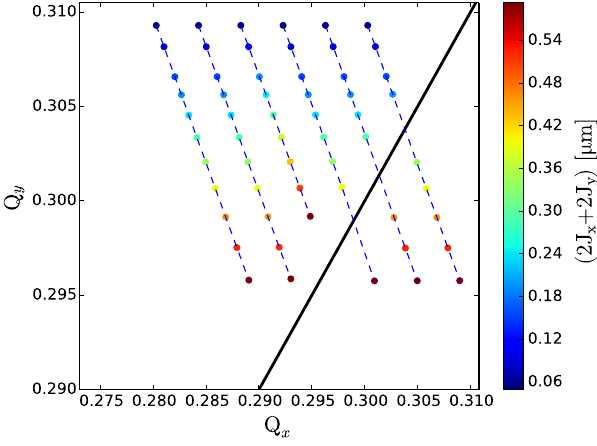
FIG. 2. Tunes from particle tracking for different initial tunes and for increasing amplitudes of the vertical kicks. The color code represents the sum of the horizontal and vertical actions. The black diagonal line indicates the resonance Q x ¼ Q y .